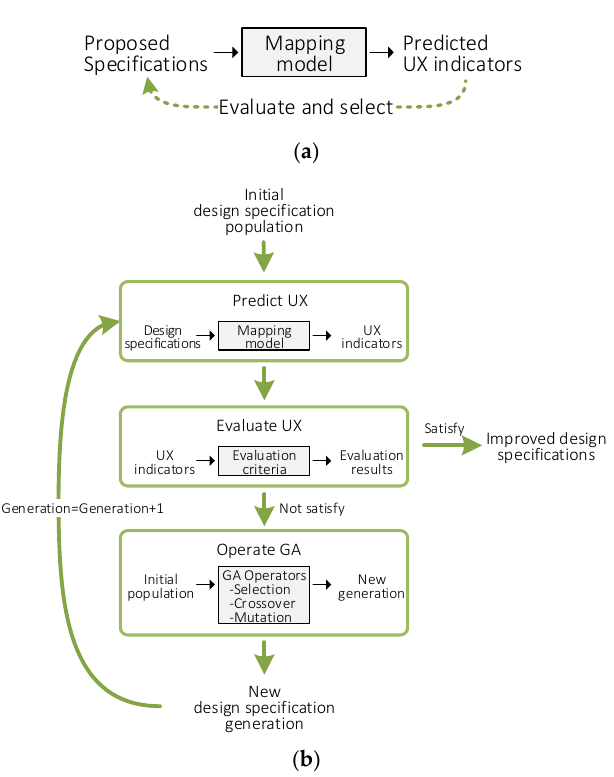
Figure 3. Implementation scenarios of the mapping model. ( a ) Evaluate and select the proposed design specifications. ( b ) Optimize the proposed design specifications.